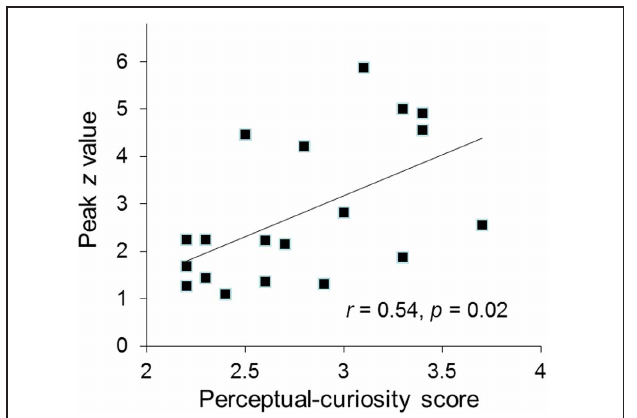
FIGURE 3 | The individual participants’ peak activation ( z value) for the perceptual-uncertainty contrast in the right AIC plotted against their perceptual curiosity score.